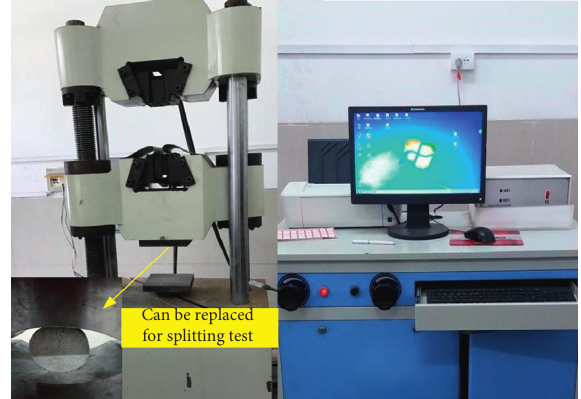
Can be replaced for splitting test Figure 8: Testing machine used in the similar material